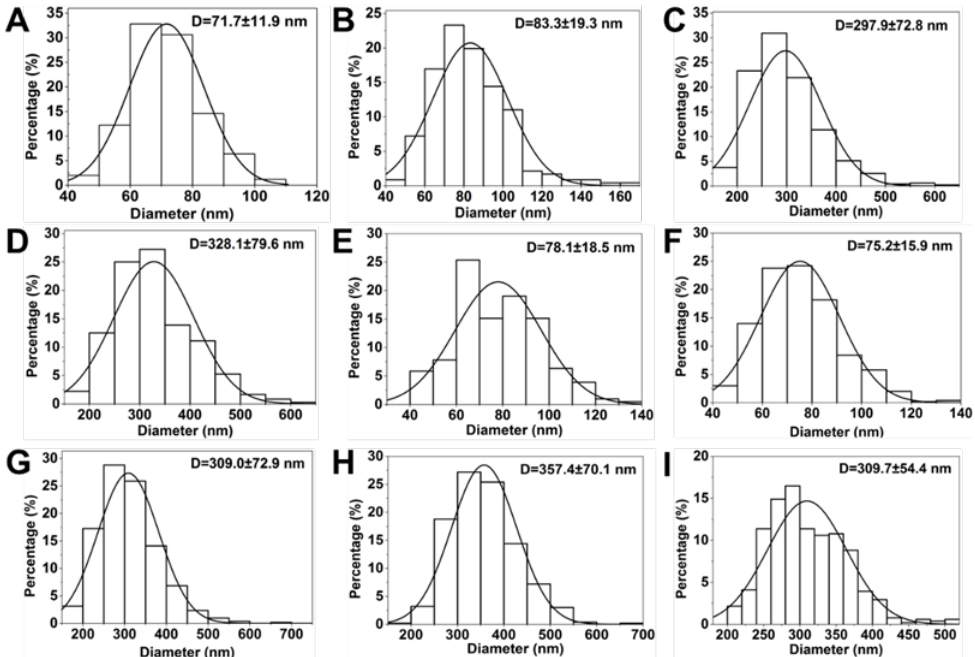
Figure 4. Histograms showing the particle size distribution of samples prepared under di ff erent operating conditions (as shown in Table 3). ( A ) 1:2, 1:2, 0.5 mL min − 1 ; ( B ) 2:1, 1:2, 0.5 mL min − 1 ; ( C )